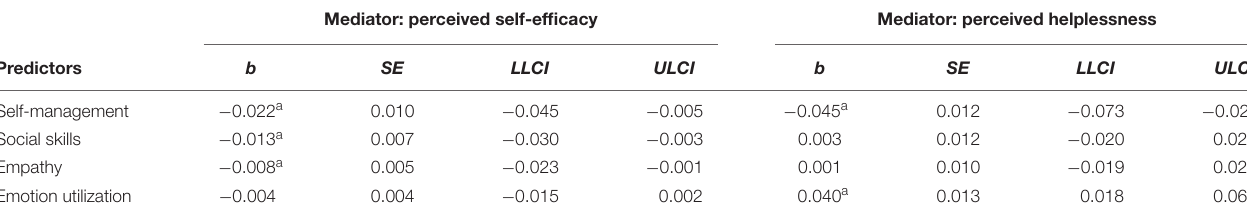
TABLE 4 | Results of indirect effect through perceived self-efficacy and perceived helplessness, respectively. Mediator: perceived